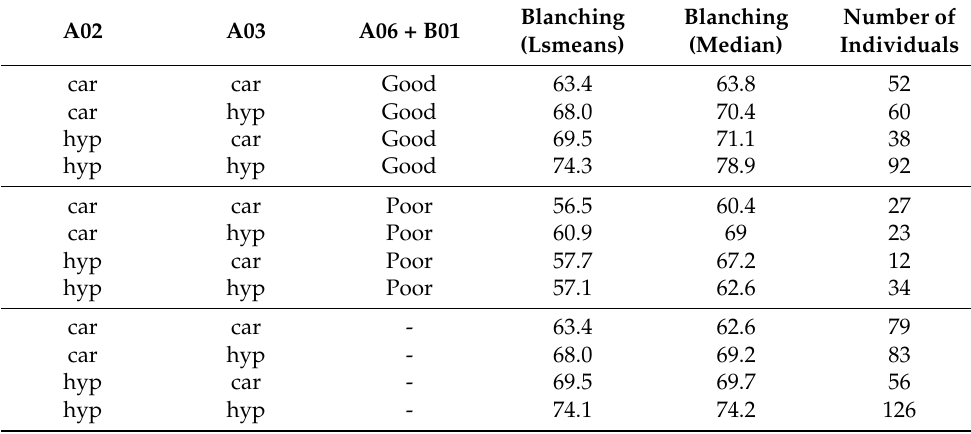
Table 2. Effect of A. cardenasii introgressions on blanching